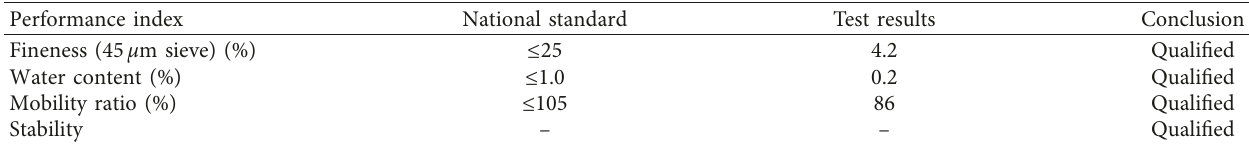
Table 3: Main properties of class II fly ash.